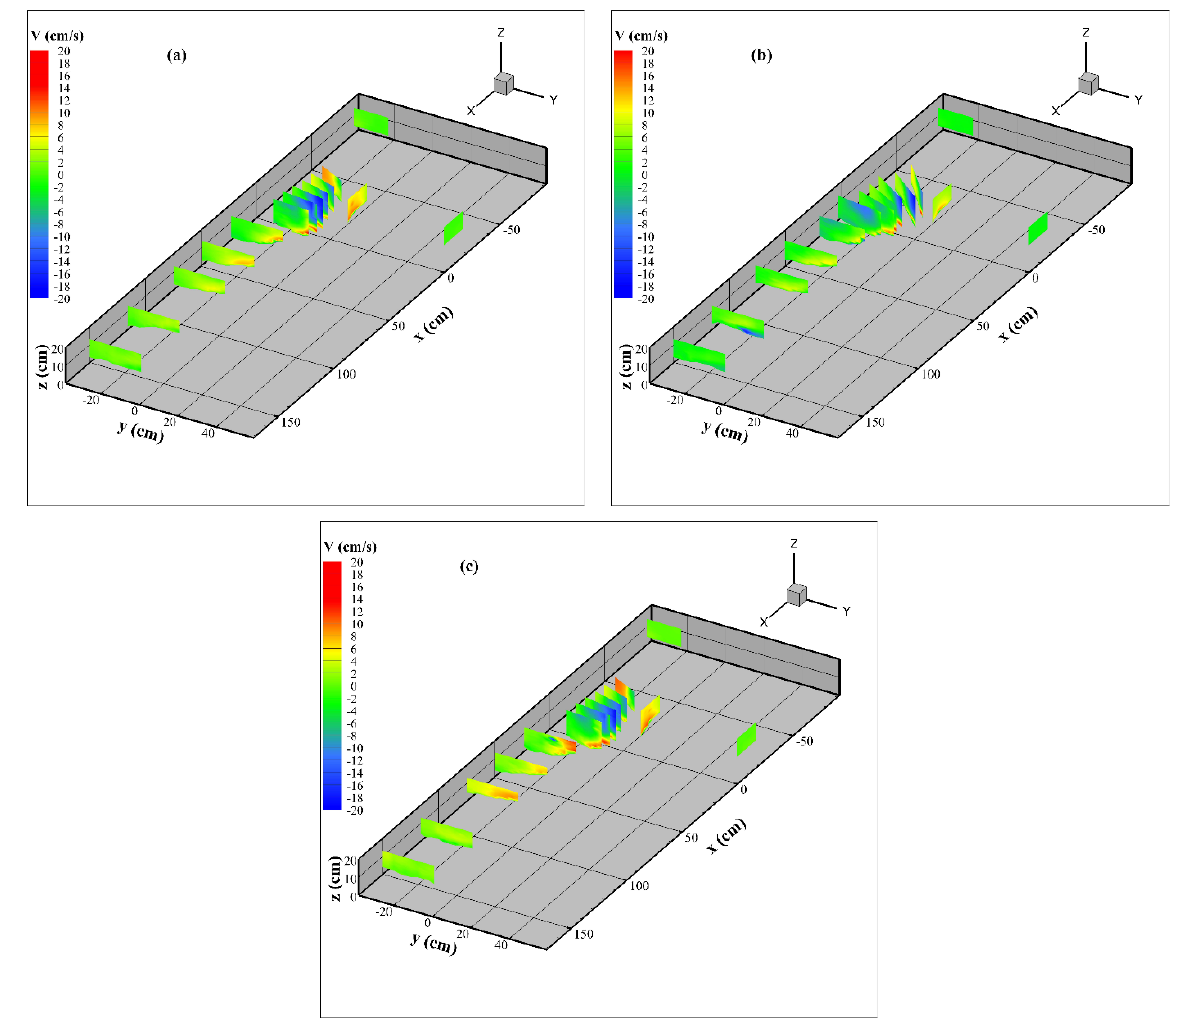
Figure 5. The spatial distribution of lateral velocities V of three cases. ( a ): case 1; ( b ): case 2; ( c ): case 3. The cross-sectional flow field distribution of the vertical velocity W is shown in Figure 6. The minimum negative values appeared on cross sections 2–6 of the core area of the confluence and in the zone at a certain distance above the bed surface, which was consistent with the flow structure of the scour hole topography. The flow field distribution of A and C was basically the same; the minimum value was approximately − 9 cm/s, but the maximum value of A (approximately 17 cm/s) was 2 cm/s larger than that of C (approximately 15 cm/s). The minimum value of flow field B reached − 13 cm/s, nearly 50% higher than the other two, and the sand bar in the separation zone showed wider upward velocity distribution. Similarly, due to the change of topography, flow field C produced a more obvious vertical vortex above the sand bar at section 8 with a negative value, and the central area of sections 11 and 12 showed a larger negative value zone. This counterclockwise vertical vortex also existed in the separation zone near the downstream junction angle, and a spiral vortex was formed after mixing with the horizontal vortex, mainly distributed on both sides of the shear layer